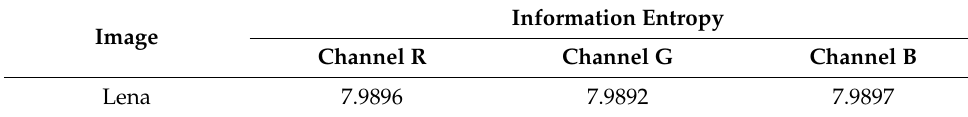
Table 4. Comparison of gray images.